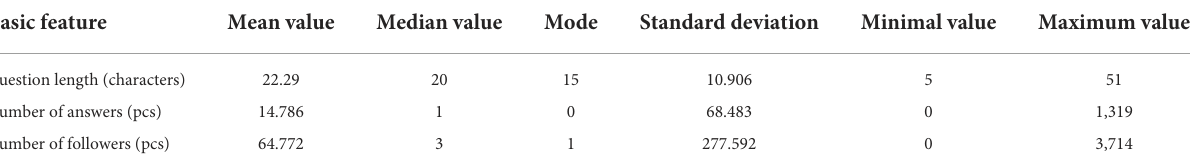
TABLE 2 Basic statistics of data on the public information needs of COVID-19 vaccine.